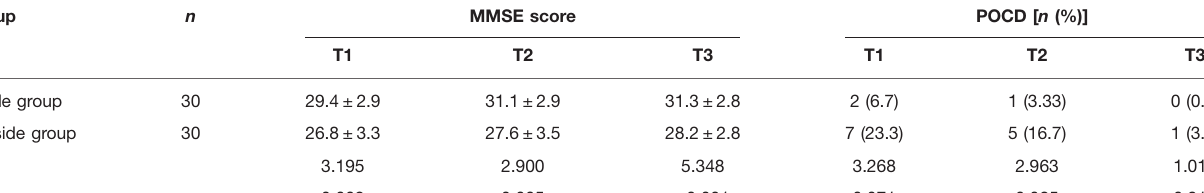
TABLE 3 | Comparison of mini-mental state examination (MMSE) score and postoperative cognitive dysfunction (POCD) incidence at different postoperative times between two groups. Group